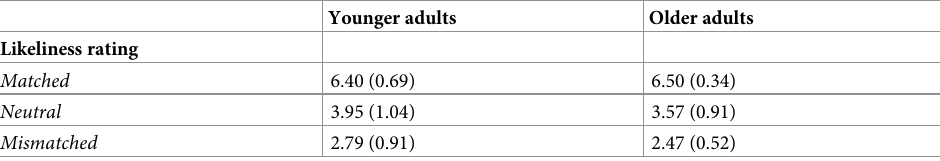
Table 2. Mean likeliness score (scale 1–7) and standard deviation for each context in each age